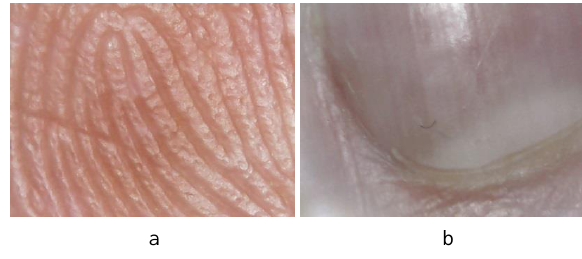
Figure 5. Sample microscopic images obtained for modeling.